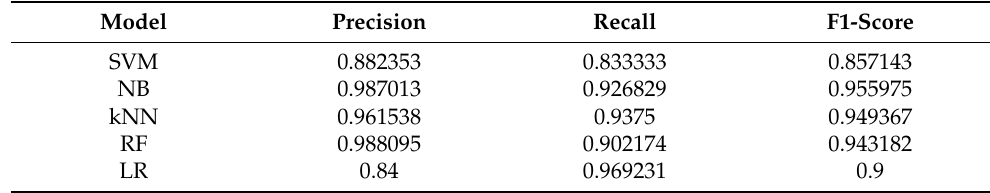
Table 7. Performance of ML models (proposed).